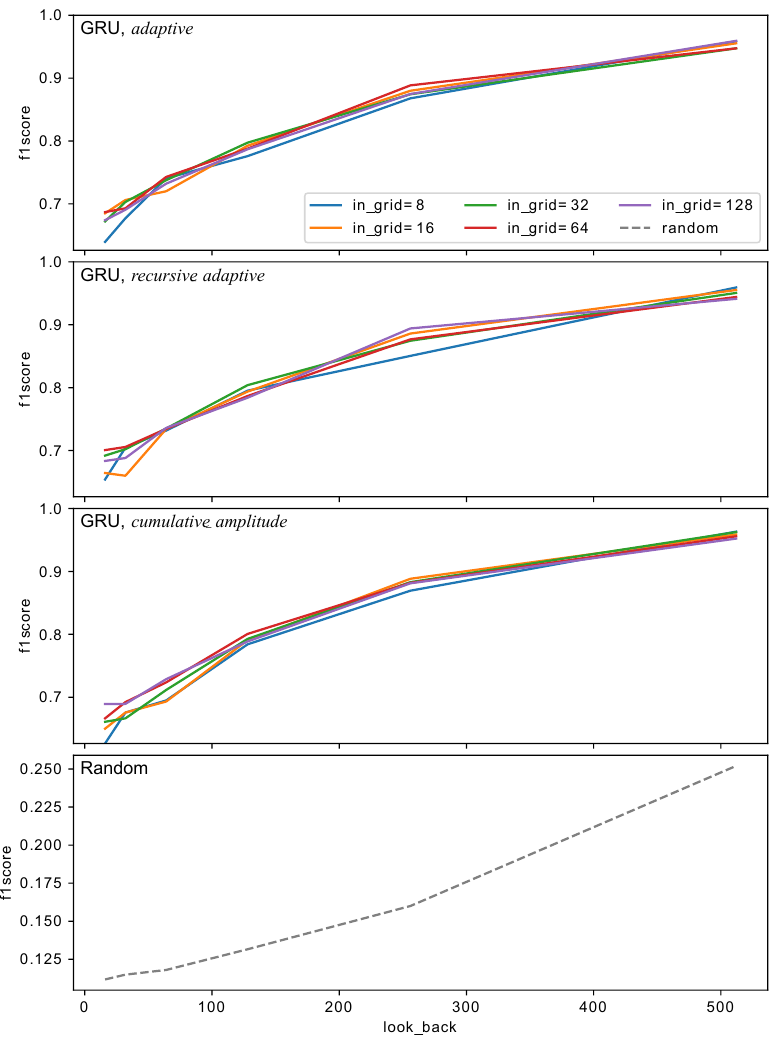
Figure 12. F 1 score as a function of look _ back for several in _ grid and in _ algorithm values. Dashed line shows Random baseline model performance for the same look _ back